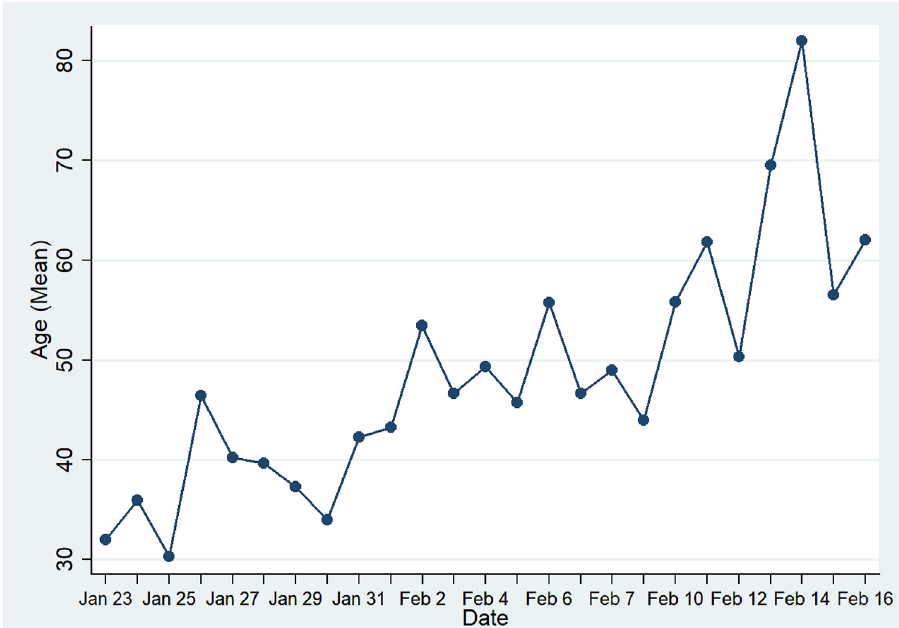
Figure 2. Mean Age of COVID-19 Cases in Shaanxi Province, China.